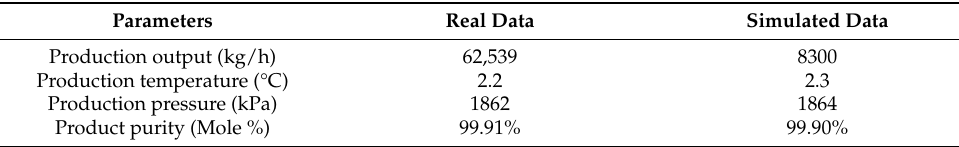
Table 5. Comparison of simulated data and actual production data.